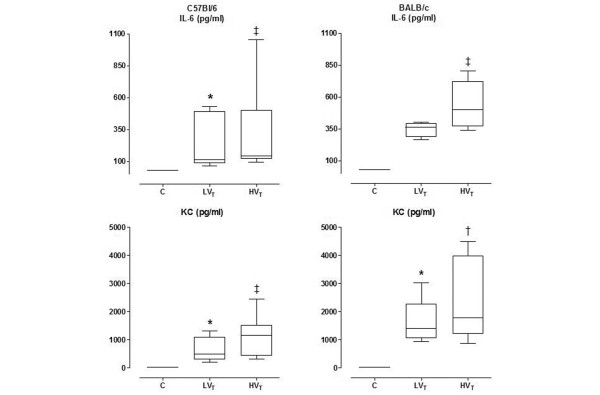
Plasma levels of interleukin (IL)-6 and keratinocyte-derived chemokine (KC). Plasma levels of IL-6 and KC in control mice, and in mice ventilated with low tidal volumes (LVT) and high VT (HVT) for five hours. Data of the two fluid strategies are pooled. Data represent median and interquartile range of six mice. Levels of IL-6 and KC in control mice were below the detection limit of the assay. *p < 0.05 vs. control; †p < 0.01 vs. LVT; ‡p < 0.001 vs. LVT.